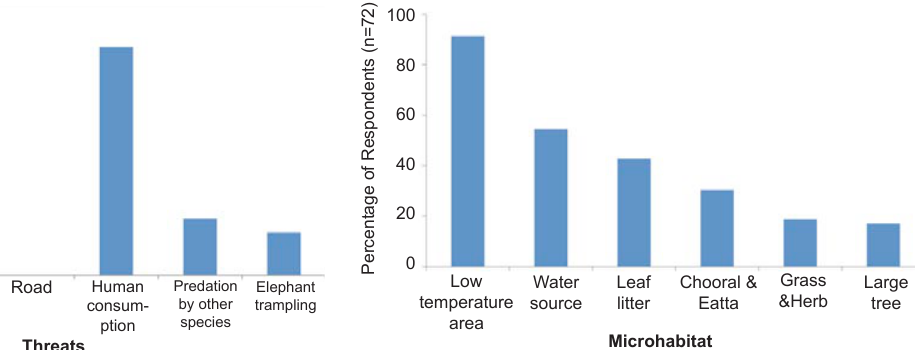
Figure 4a. Typical microhabitats associated by respondents to Vijayachelys silvatica in the study area